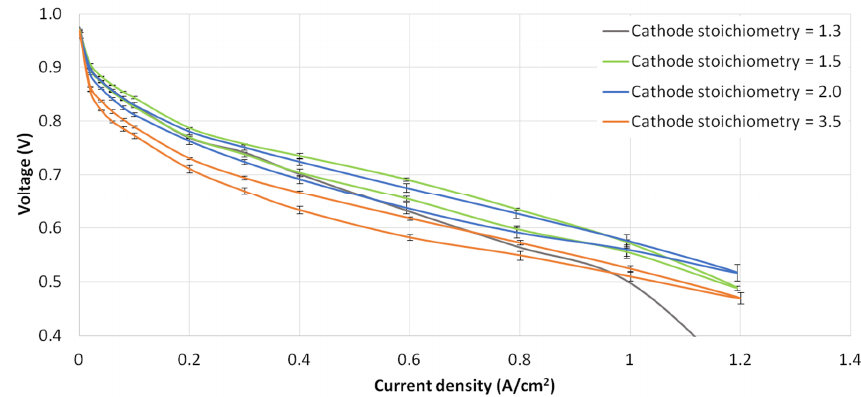
Figure 6. Polarization curve for cathode stoichiometry tests (λ c = 1.3, 1.5, 2.0, 3.5). λ c = 1.5 corresponds to the reference conditions. Forward curve (increasing current) at the bottom; backward curve (decreasing current) at the top. Error bars corresponding to the three repetitions are included for each measurement point.